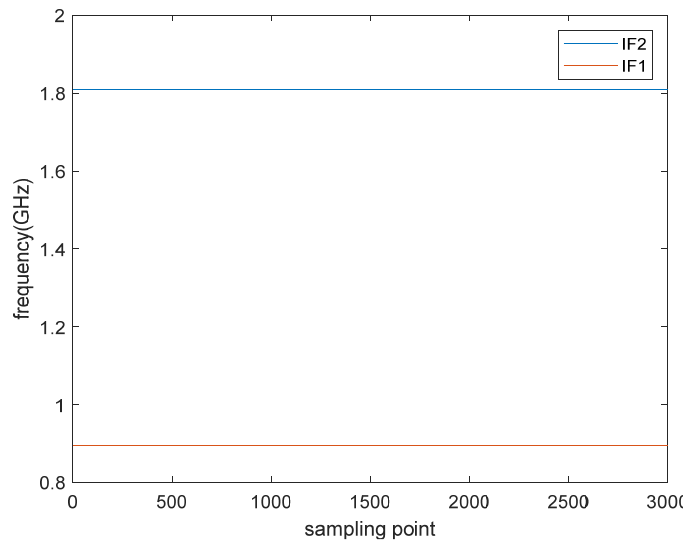
Figure 6. The extracted IF lines.